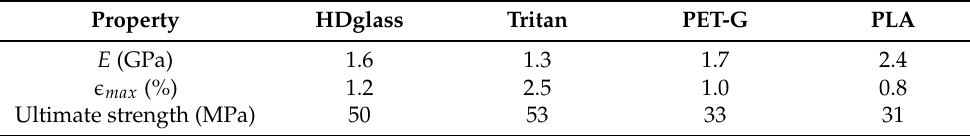
Table 6. Mechanical properties calculated from data acquired in stress–strain tests.